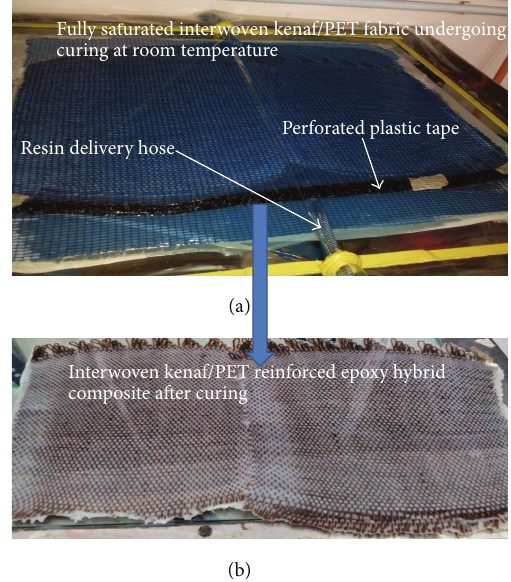
Figure 4: Consolidation and curing process. (a) Fully saturated interwoven fabric during consolidation and curing. (b) Cured inter- woven hybrid composite.